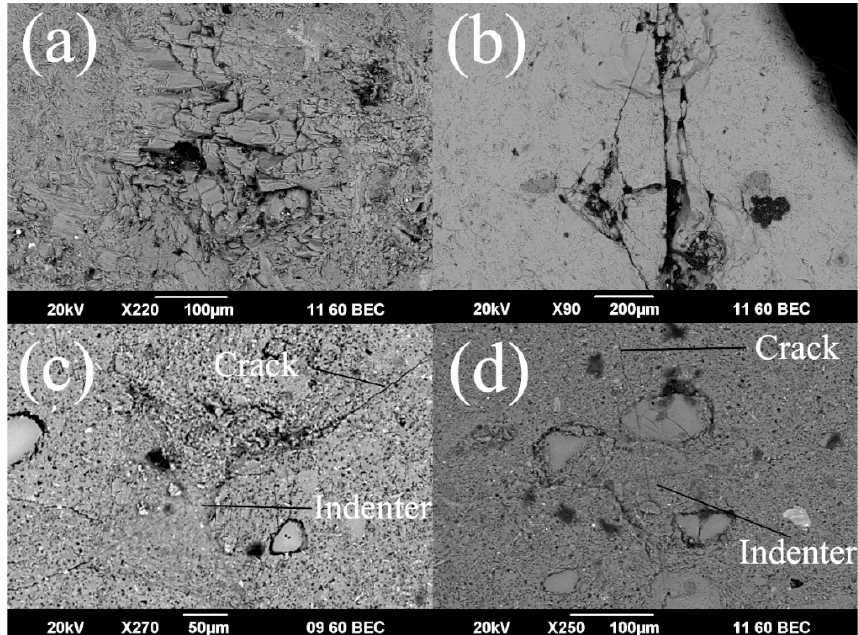
Figure 4. SEM images of Vickers indenter ( a ) natural basalt; ( b ) basalt glass ceramics; ( c ) sintered basalt; ( d ) composite material.